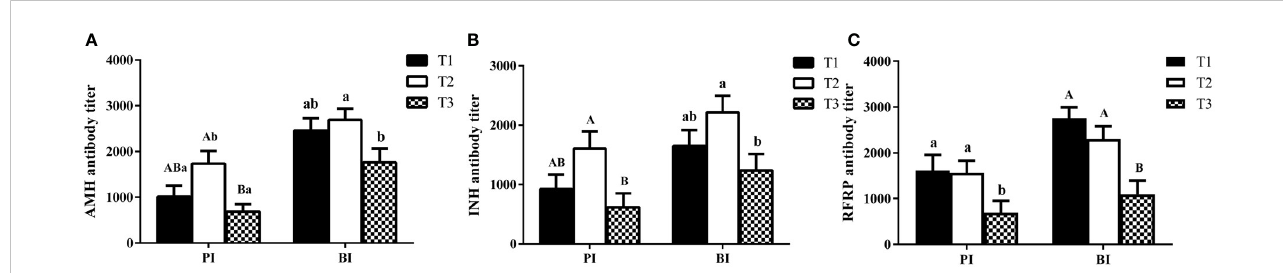
FIGURE 3 The titers of IgG antibody in buffaloes after immunization with various concentration of AMH-INH-RFRP DNA vaccine. Anti-AMH (A) , anti-INH (B) , anti-RFRP (C) were detected by ELISA. Data are presented as mean ± SEM. The bars with different letters indicate signi fi cant differences ( a,b P < 0.05, A,B P <